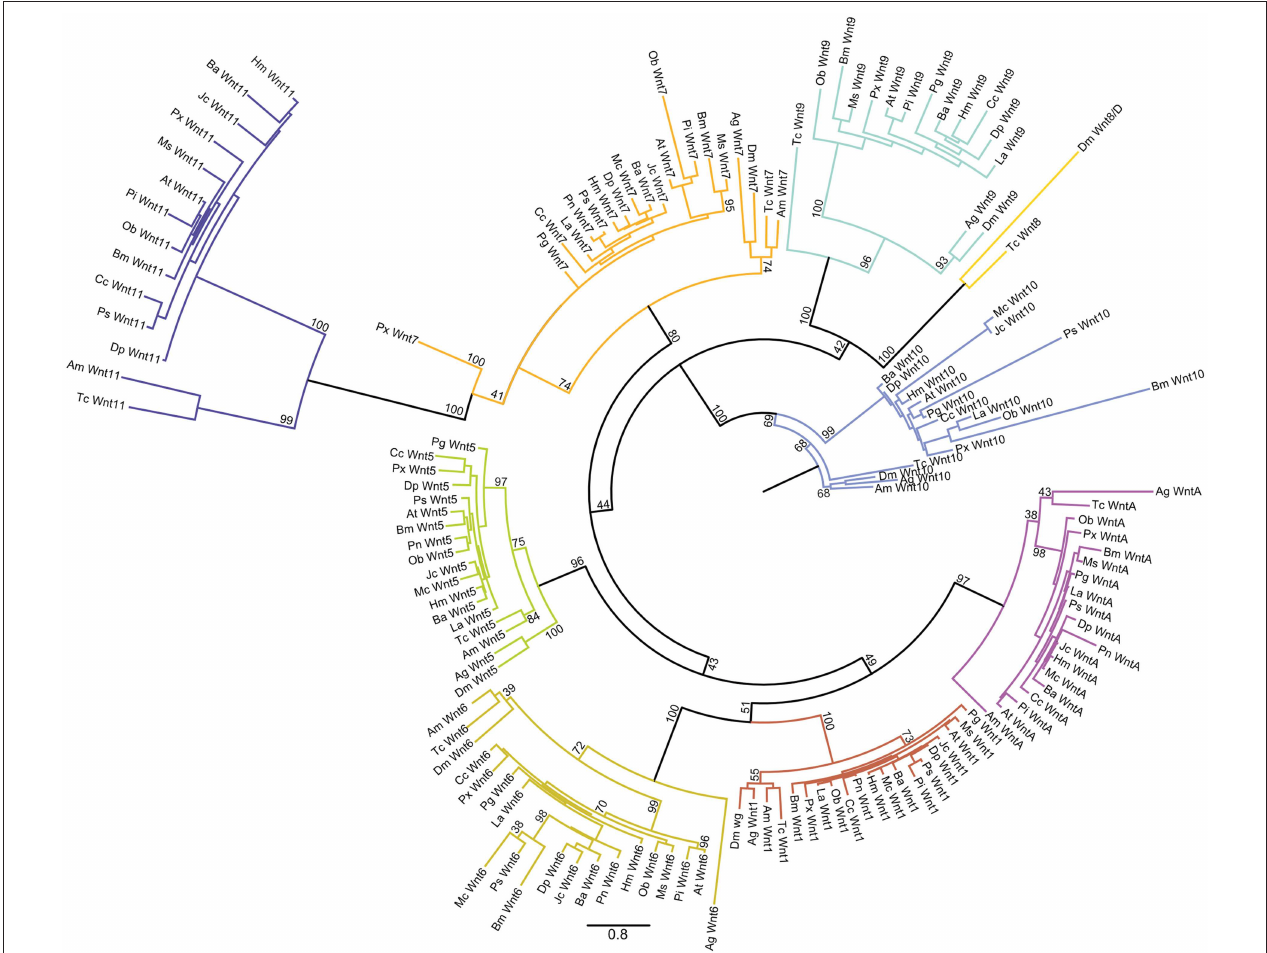
FIGURE 2 | Maximum likelihood analysis of Lepidopteran Wnt genes. Circular maximum likelihood tree of all Wnt sequences used in our study from the 16 lepidopteran species as well as the four other insects. The bootstrap support for branches is indicated. Scale bar showing the number of substitutions compared to the length of branches between the